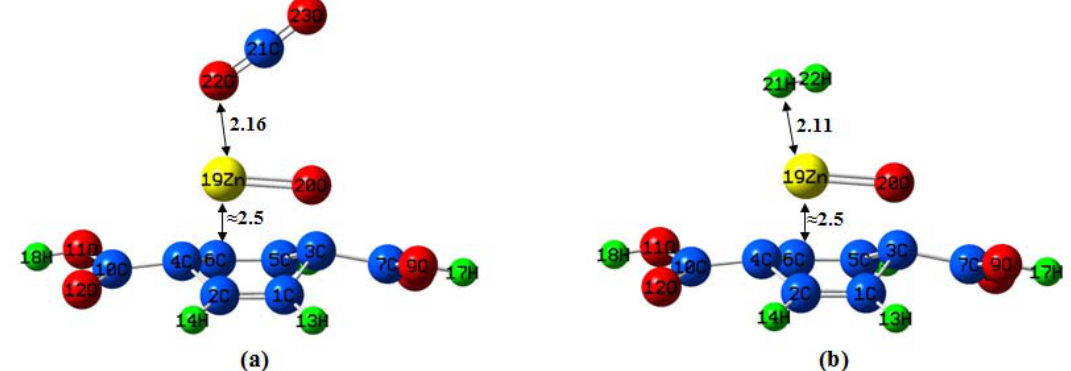
Fig. 5: Optimized unit cell of (a) H